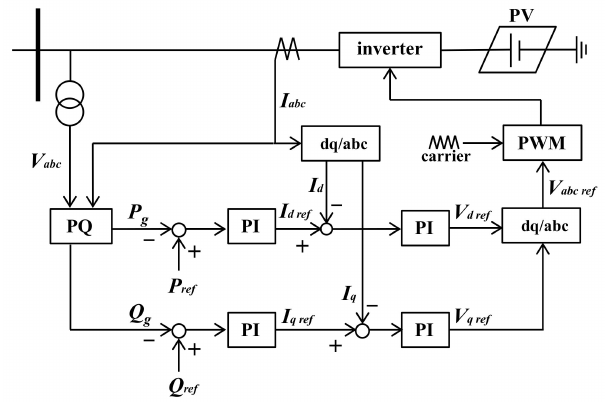
Figure 6. Control model of the PV system.